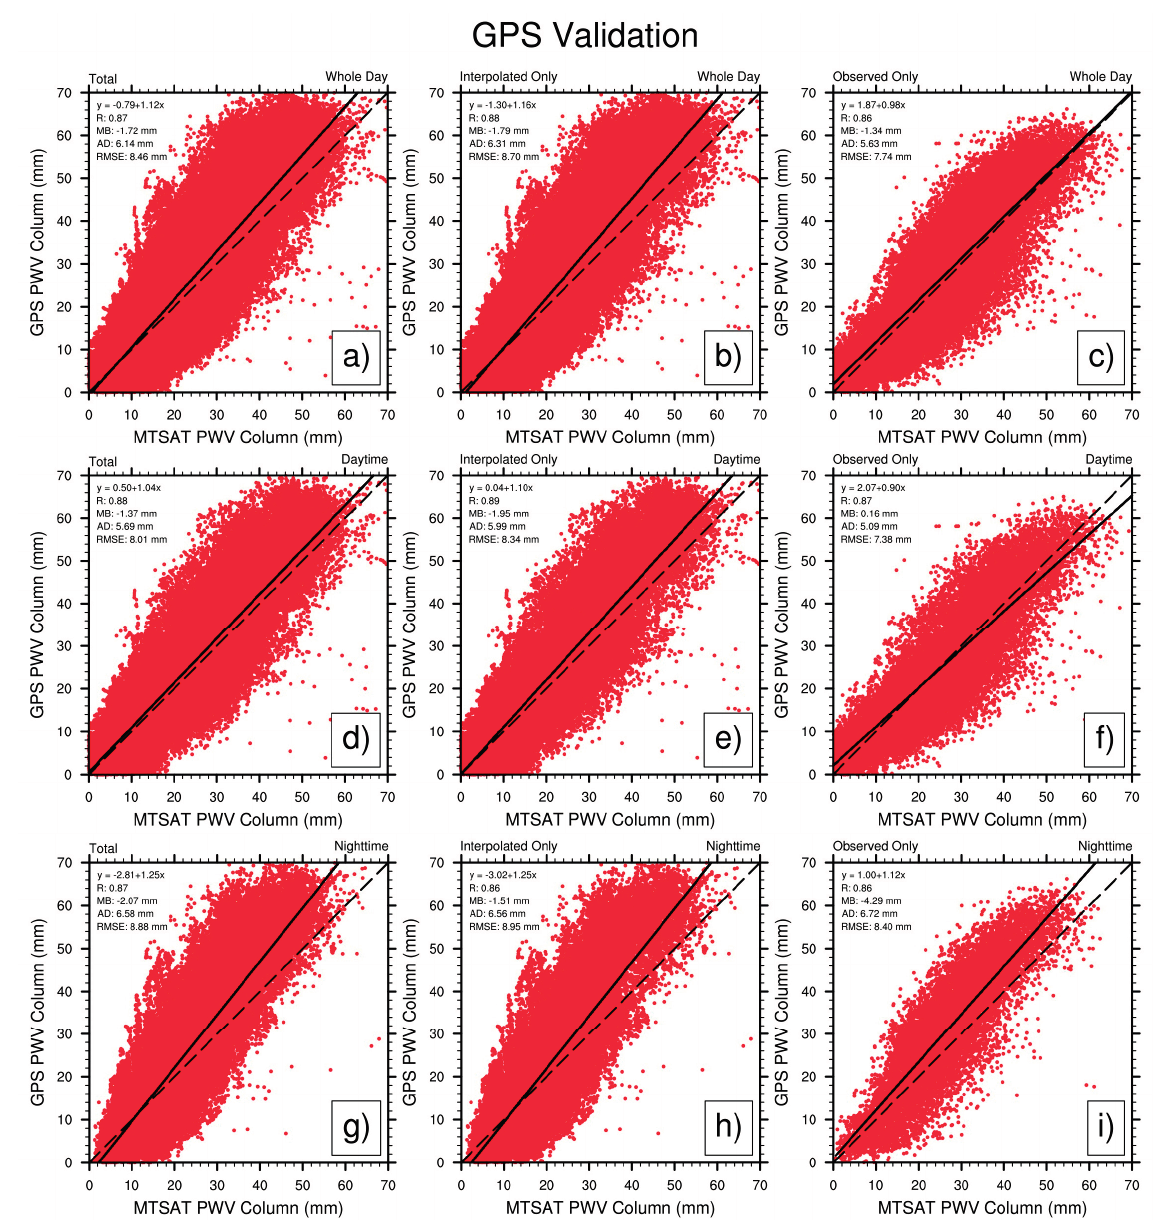
Figure 5. Validation of Multi-functional Transport Satellite (MTSAT) derived PWV with GPS-derive PWV: ( a ) reconstructed data (whole day); ( b ) interpolated data over cloudy pixels (whole day); ( c ) observed data only (whole day); ( d ) reconstructed data at daytime; ( e ) interpolated data over cloudy pixels at daytime; ( f ) observed data at daytime; ( g ) reconstructed data at night; and ( h ) interpolated data over cloudy pixels at night; ( i ) observed data at